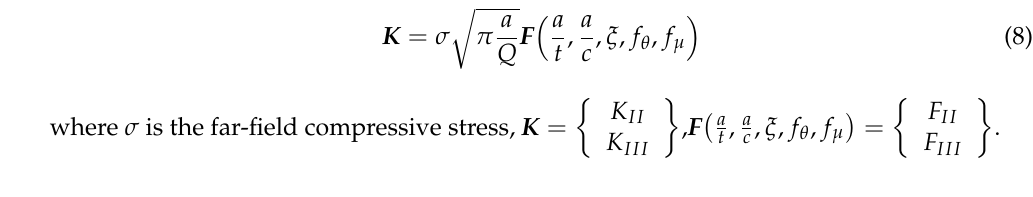
Table 3. The sub-curve fitting constants in Equation (10) h i . a/t = 0.2